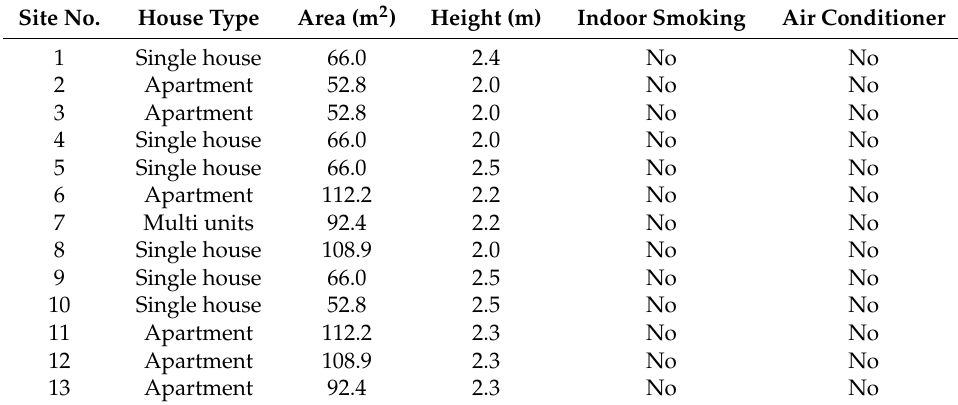
Table 1. Characteristics of sampling